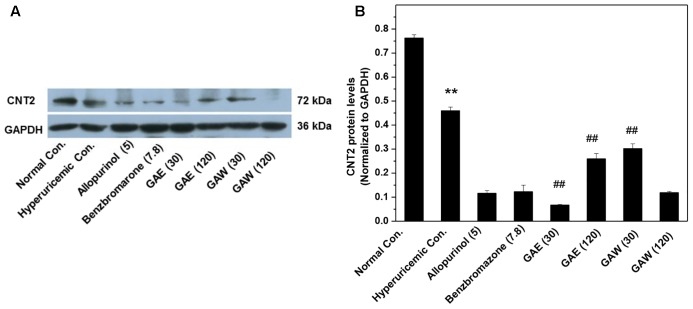
Effects of G. applanatum extracts on protein levels of intestines transporters. Kidney cortex protein was extracted for Western blot analysis of CNT2 (A,B). ∗∗P < 0.01 as compared to the normal control; ##P < 0.01 as compared to the hyperuricemia control.